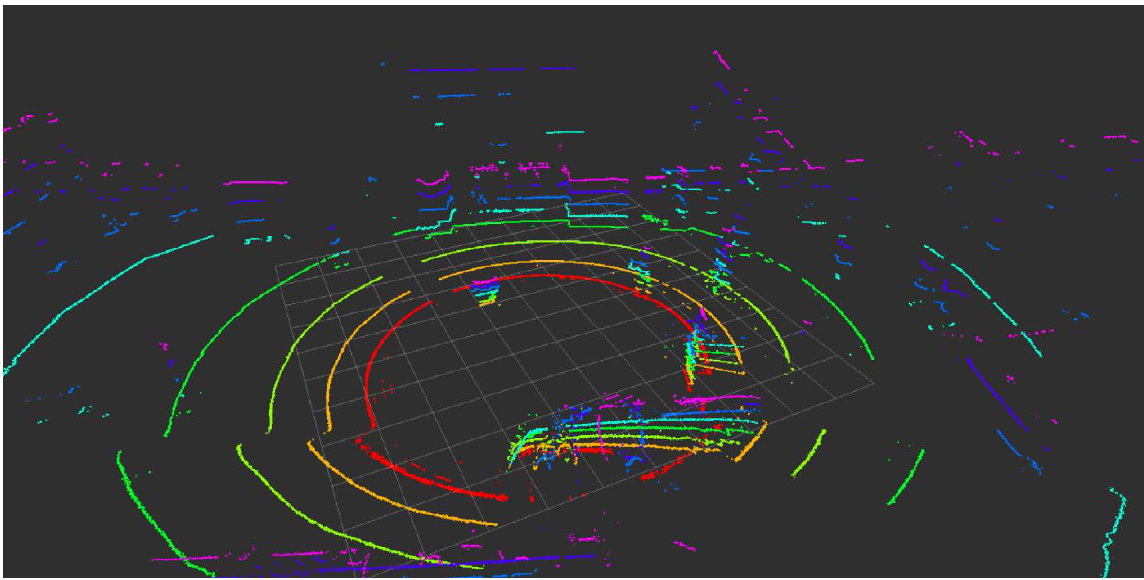
Figure 5. Pedestrian footfall on a retail high street traffic as imaged by an eight-beam LiDAR.